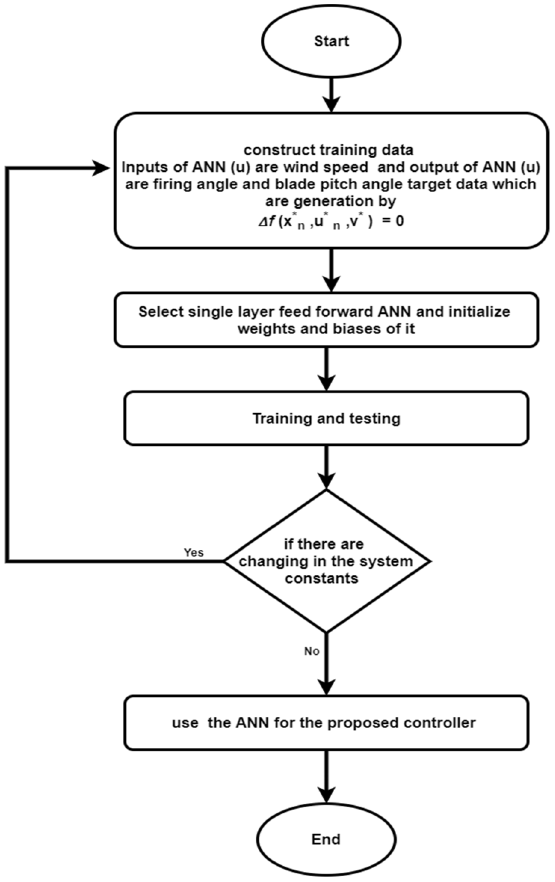
Figure 4. Flow chart of ANN process.